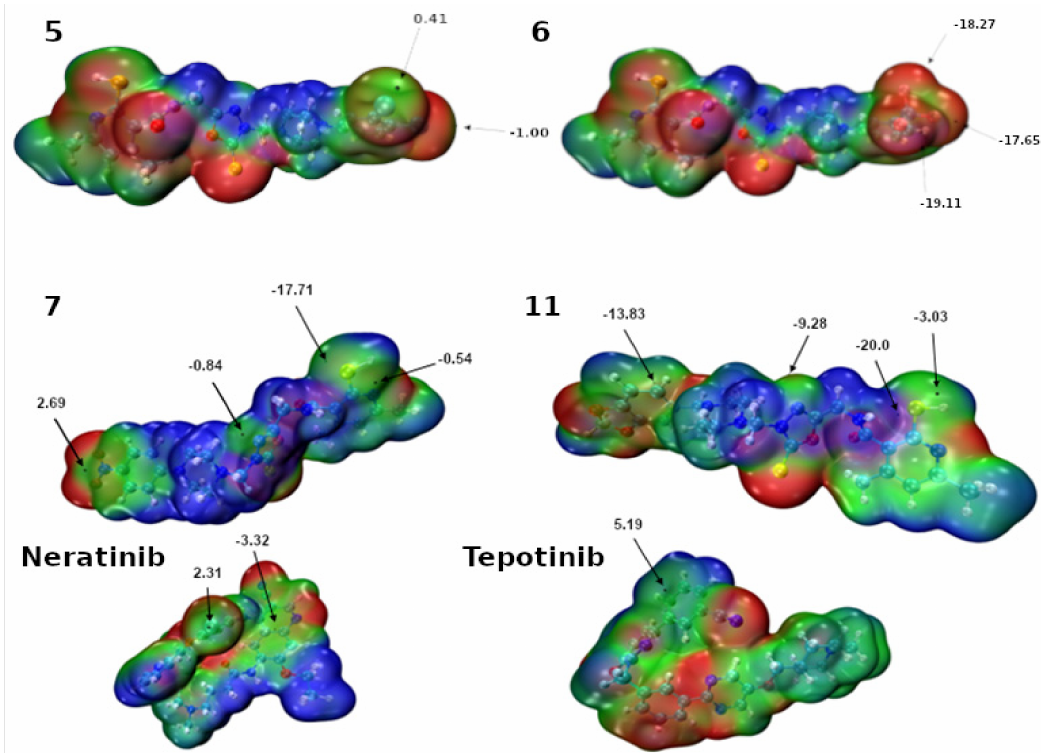
Figure 11. Molecular Electrostatic Potential (MEP) of 5 , 6 , 7 and 11 compounds as well as reference drugs: Neratinib and Tepotinib computed at the MN15/def2-TZVP level of theory. The isosurface was set from − 0.001 a.u. to 0.001 a.u. Color coding: red—negative values, blue—positive values. Black dots and arrows mark the presence of V ext (extremas on the MEP